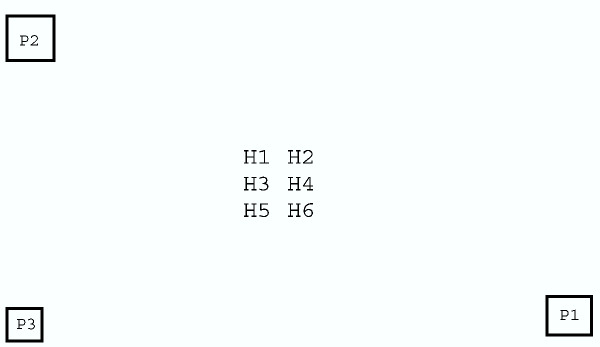
Example schematic.